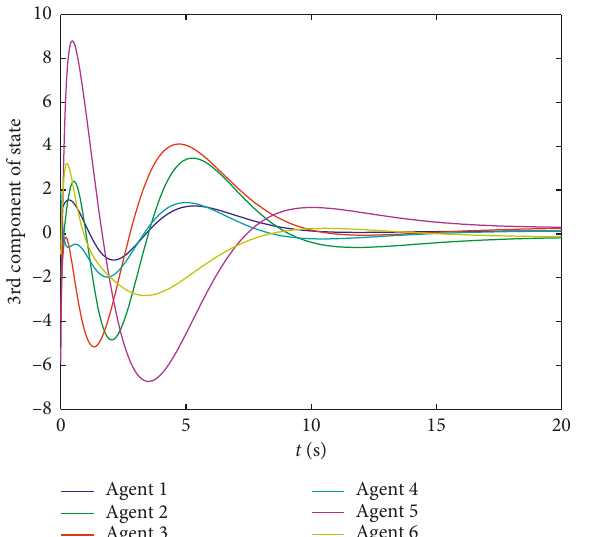
i, 3 via protocol (17).